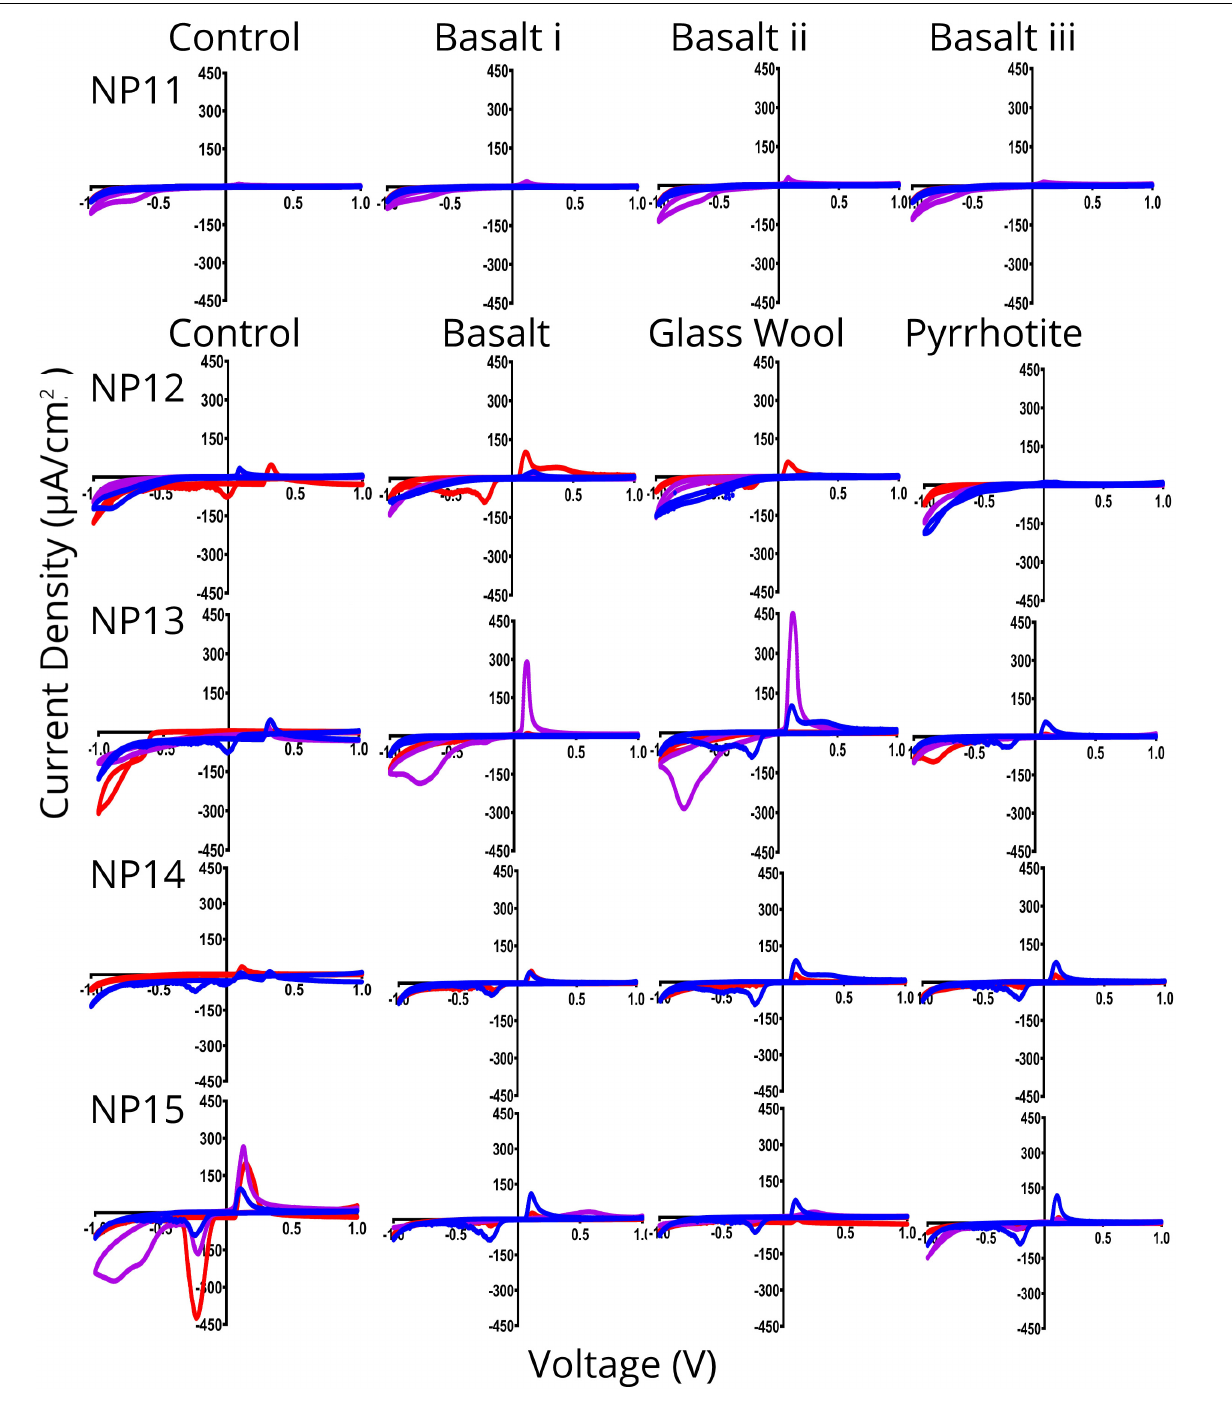
FIGURE 4 | Cyclic voltammetry (CV) scans of indium tin oxide (ITO) electrodes from cathodic poised potential experiments. In each plot, red lines are scans of electrodes immediately before incubation, blue lines are scans of electrodes immediately after incubation, and purple scans are from fresh ITO electrodes inserted into incubated media. Overall, electrodes have current peaks at –0.8, –0.35, and 0.2 V vs. Ag/AgCl on both the incubated ITO electrode at the end of experiment (blue) and on a fresh ITO electrode inserted into incubated media (purple), indicating redox couples likely equivalent to H 2 /O, Fe 2 /O 2 , and an as yet unknown mechanism, respectively. Note that ‘-’ here indicates current and voltage direction and not mathematical negative so increasingly negative values represent increasing current density in the opposite electron flow direction. Plots are average of triplicate CV scans at 0.1 V/s (duplicate for NP11 Tend i, NP11 Tend ii, NP12 Tend i, and NP13 Tend